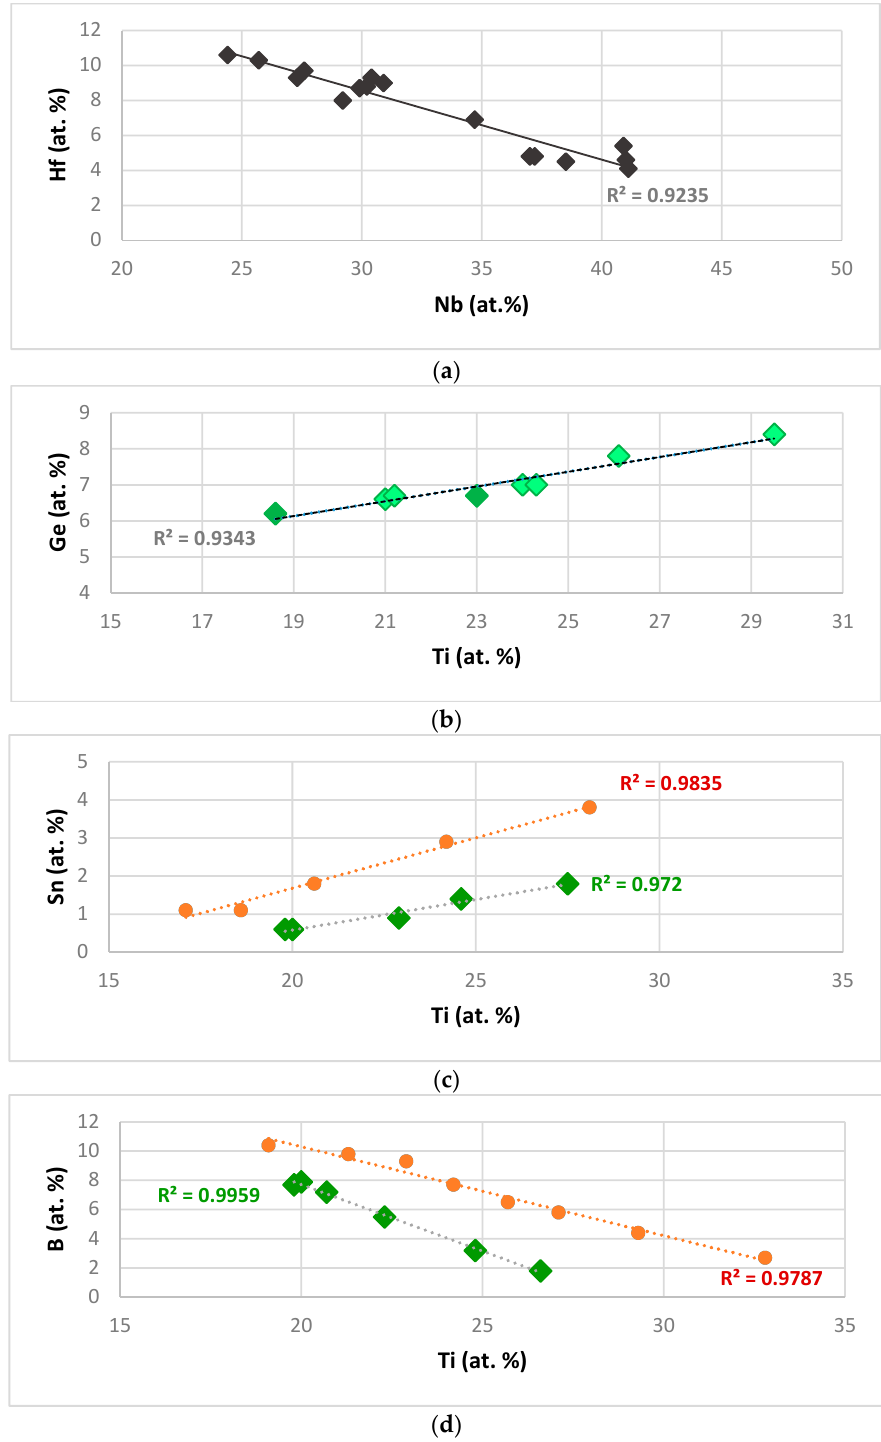
Figure 1. Relationships between alloying elements in Nb 5 Si 3 . ( a ) Shows the relationship between Hf (at.%) and Nb (at.%) in Nb 5 Si 3 . ( b – d ) show the relationships respectively between Ge, Sn and B (at.%) and Ti (at.%) in Nb 5 Si 3 . In ( b ) the dark green diamonds are for alloys with Ge and Sn. In ( c ) and ( d ) the green diamonds are for alloys with B and with no Mo, respectively.